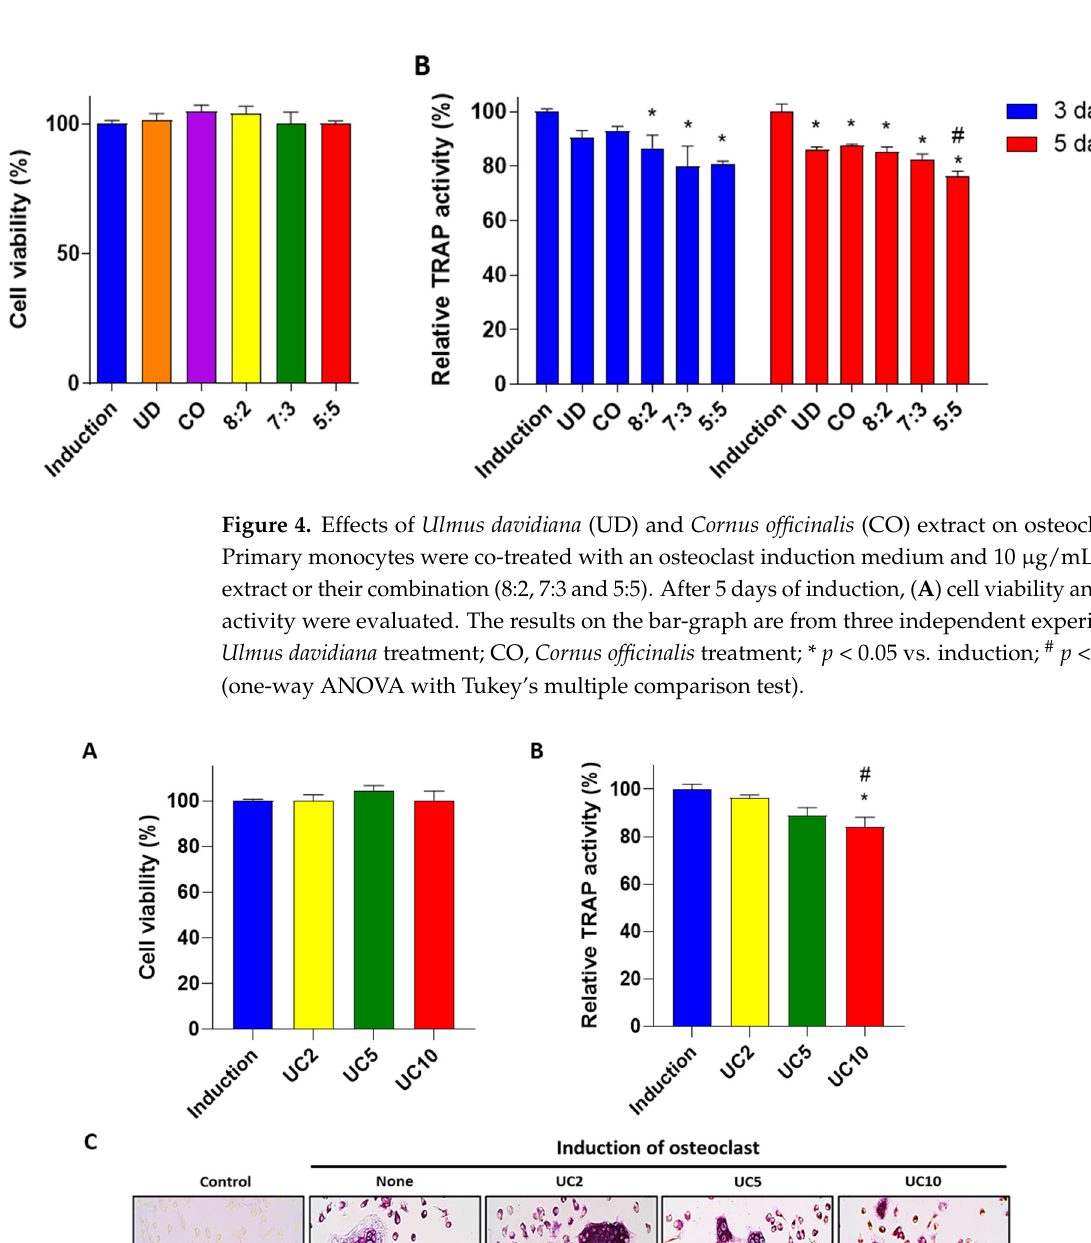
Figure 5. Effects of UC extract on the activity of osteoclasts in mouse primary osteoclasts. Primary monocytes were co-treated with an osteoclast induction medium and different concentrations of UC 5:5 extract (2, 5 and 10 µ g/mL). After 5 days of osteoclast induction, ( A ) cell viability and ( B ) TRAP activity were assessed. ( C ) Representative images of TRAP-stained cells were obtained by a light microscope. The results on the bar-graph are from three independent experiments. UC, Ulmus davidi- ana (UD) and Cornus officinalis (CO) 5:5 ratio treatment; * p < 0.05 vs. induction; # p < 0.05 vs. UC2 (one-way ANOVA with Tukey’s multiple comparison